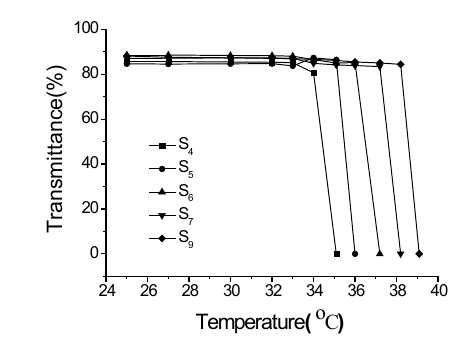
Figure 3. Transmittances as a function of temperature for the P(NIPAAm-co-Am) hydrogels with different NIPAAm/Am molar